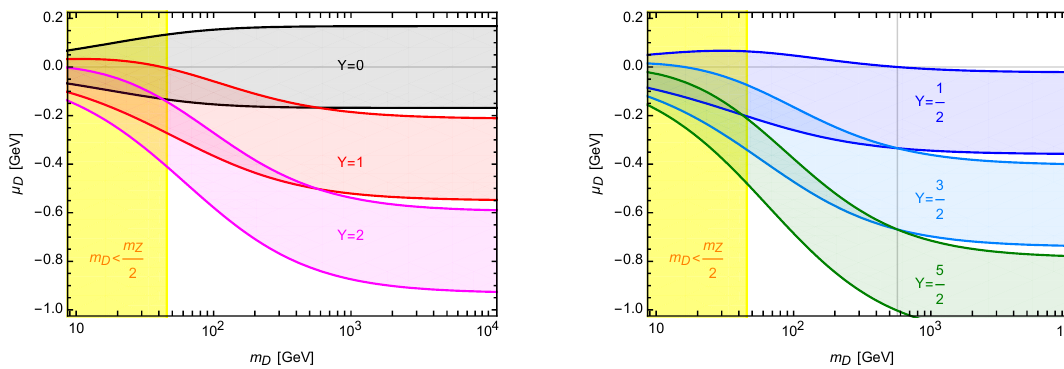
Figure 2. The feasible region in the m D – µ D parameter space, where the lightest state is neutral, lies within the two lines, where the upper one comes from the Q = − 1 state and the lower one from Q = 1 . For multiplets with maximal hypercharge, Y = I , the region above the upper line is also allowed. The yellow shaded region is excluded by Z decays into the DM multiplet